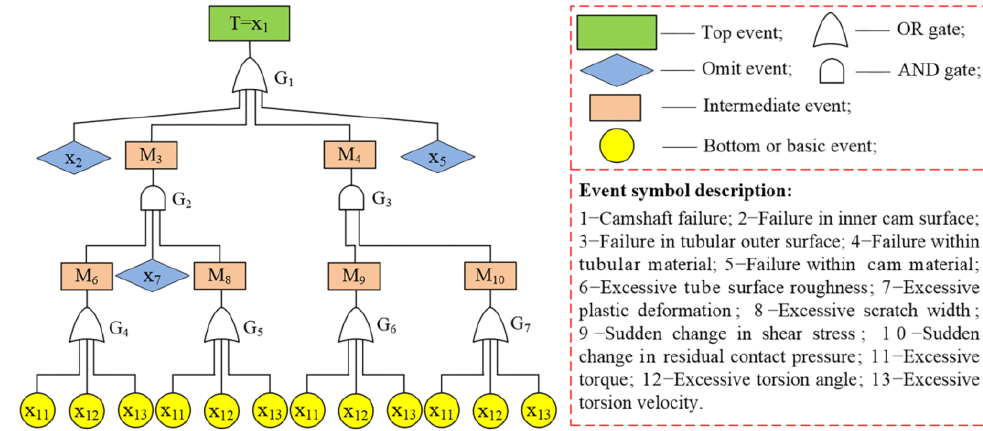
Figure 14. Failure tree model in this study, including the symbol description of each event and symbol of each logic gate.